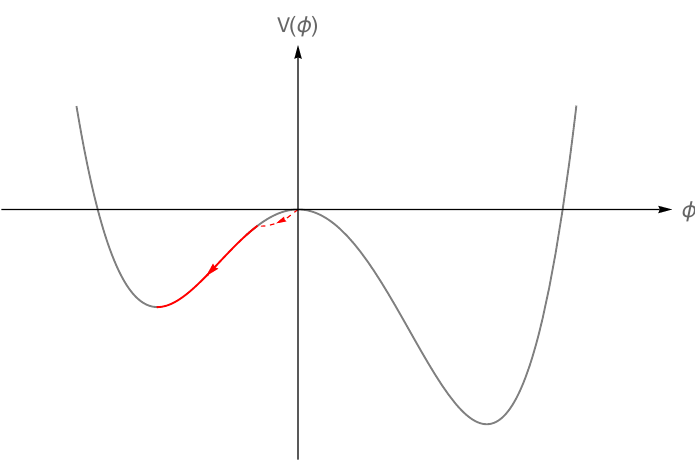
Figure 6 . The red solid line with arrows denote the trajectory of the near horizon value of the scalar field when we lower the temperature.